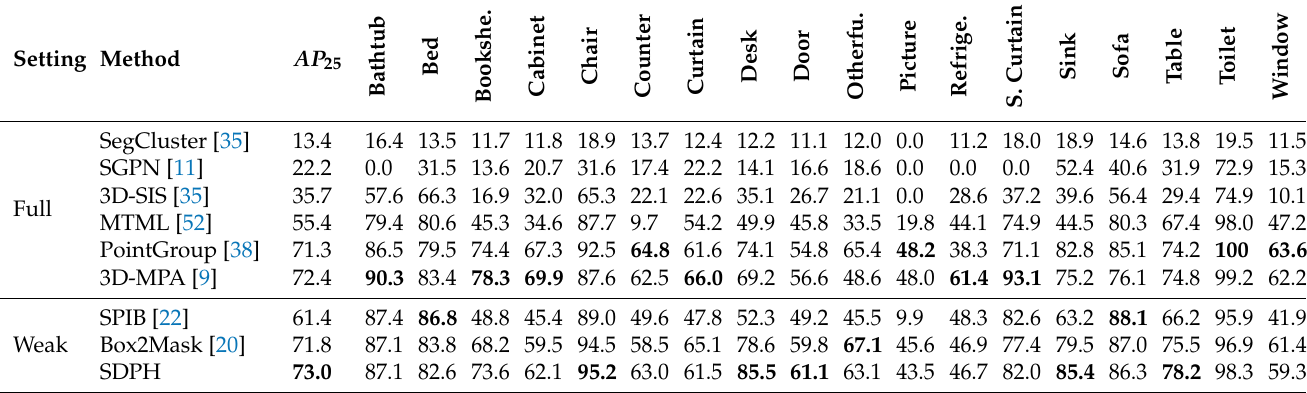
Table 2. Quantitative comparison with state-of-the-art methods on ScanNet-v2. The highest perfor- mance in each column is marked in